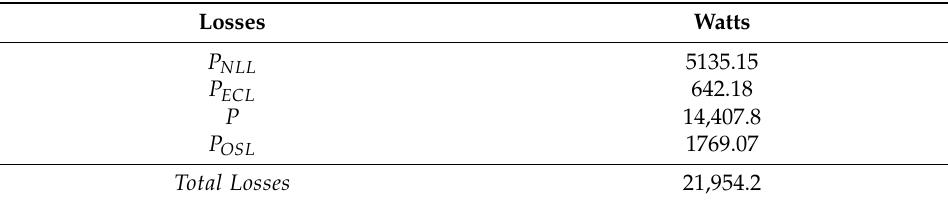
Table 4. Transformer losses with harmonic profile design calculated.